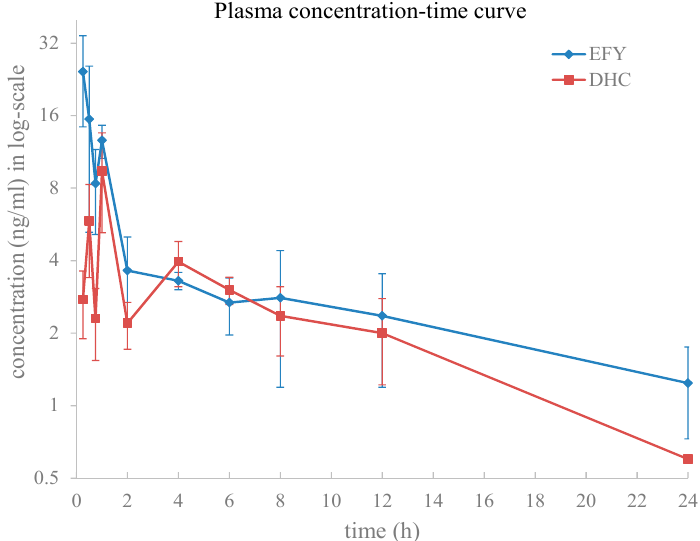
Figure 5. Mean plasma concentration in log-scale-time profiles of DHC in rats following oral administration either in an EFY form or in pure form at an equivalent dose of 97.5